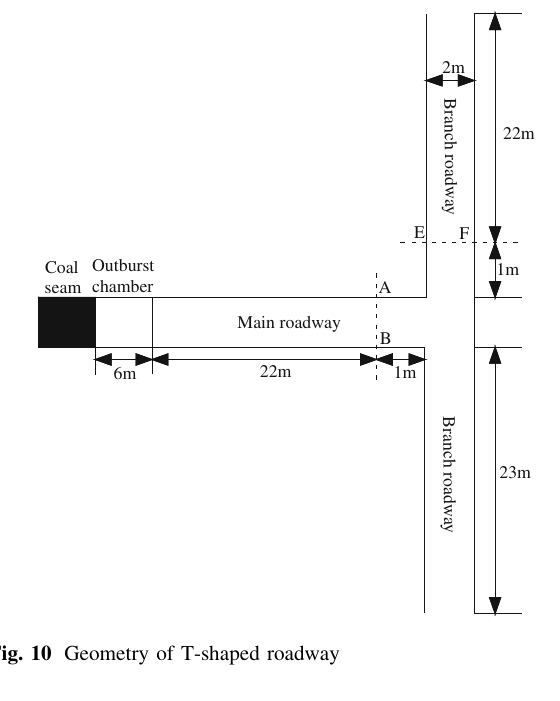
Fig. 10 Geometry of T-shaped roadway